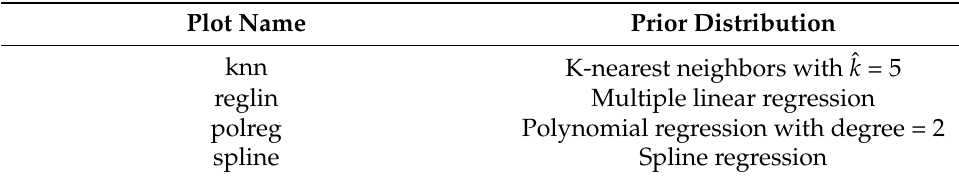
Table 2. Prior relation between response variable and covariates.